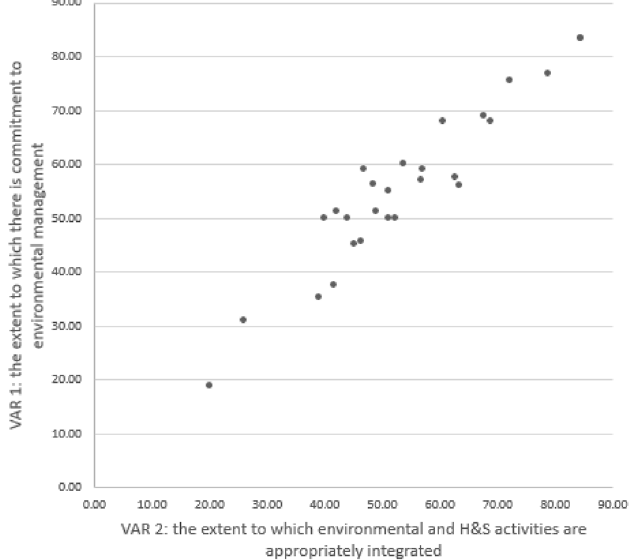
Fig. 4. Scatter plot to indicate the relation between the extent to which there is commitment to environmental management (Variable of VAR1), and (ii) the extent to which environmental and H&S activities are appropriately integrated. Correlation coef fi cient 0.995, p <